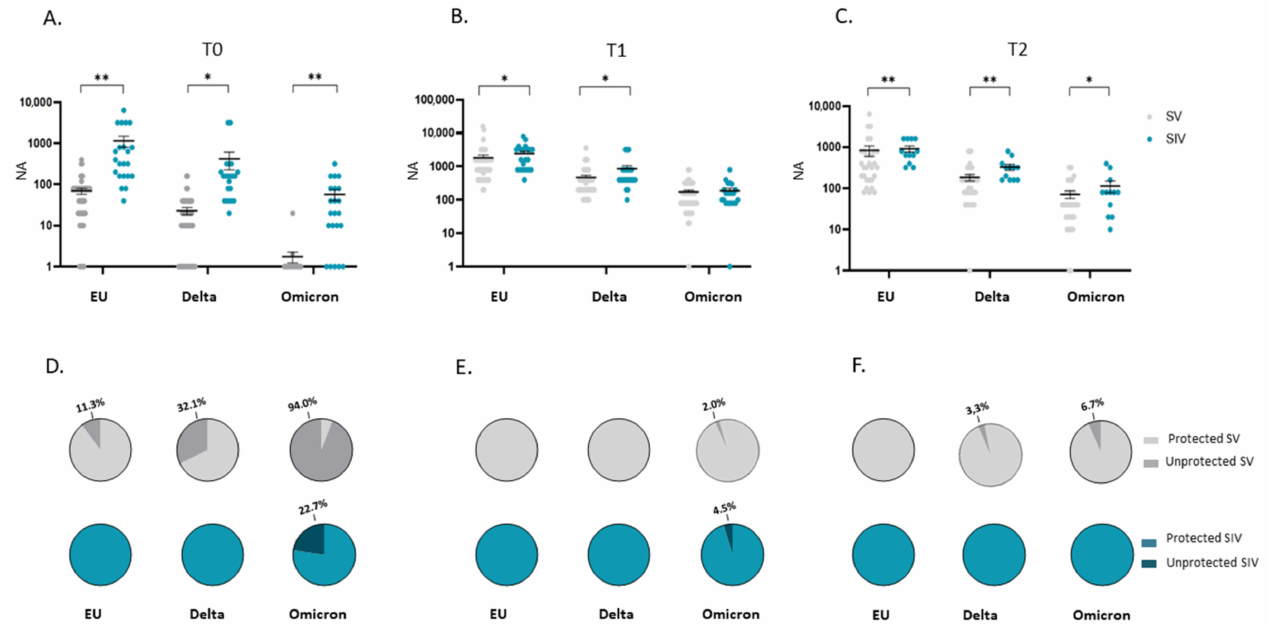
Figure 3. Comparison of plasma neutralizing activity (NA) in SARS-CoV-2 Vaccinated Subjects (SV) and SARS-CoV-2 Infected and Vaccinated Subjects (SIV). NA in plasma from SIV was higher than in SV against all the examined VOCs at all time points: T0 ( A ), T1 ( B ), and T2 ( C ). The pie charts show the percentage of SV (grey) and SIV (Blue) lacking serum NA against the EU, Delta and Omicron variants at T0 ( D ), T1 ( E ), and T2 ( F ), respectively. * p < 0.05, ** p <